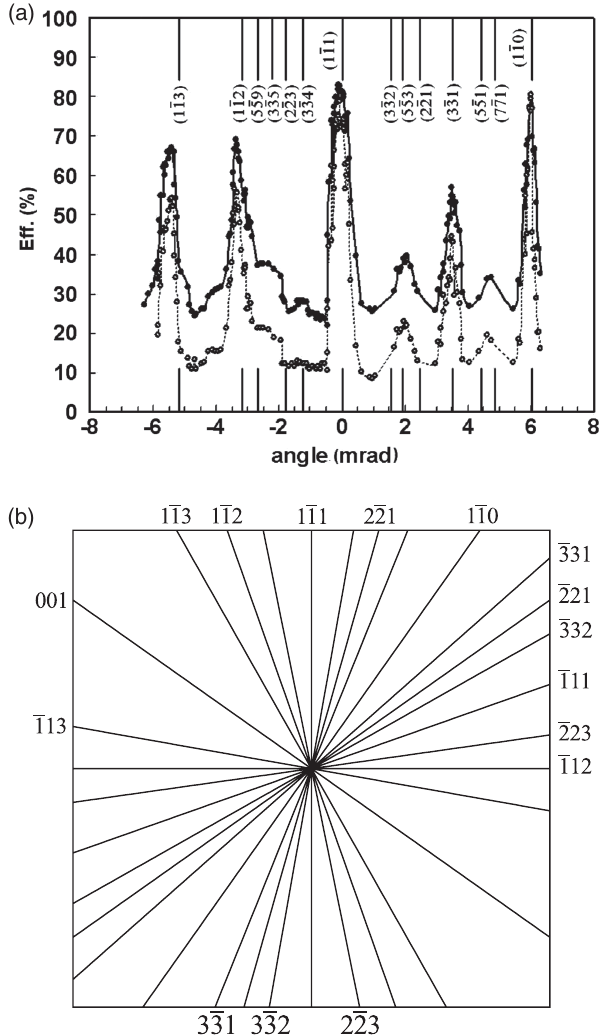
FIG. 4. (a) The efficiency of the accelerated beam extraction as a function of the horizontal angle of the goniometer. The upper curve—the full effect of the deflection due to the planar chan- neling and incoherent scattering; the lower curve—the contribu- tion of the planar channeling. (b) Stereogram of the most strong atomic planes around the h 110 i crystal axis of the silicon crystal.